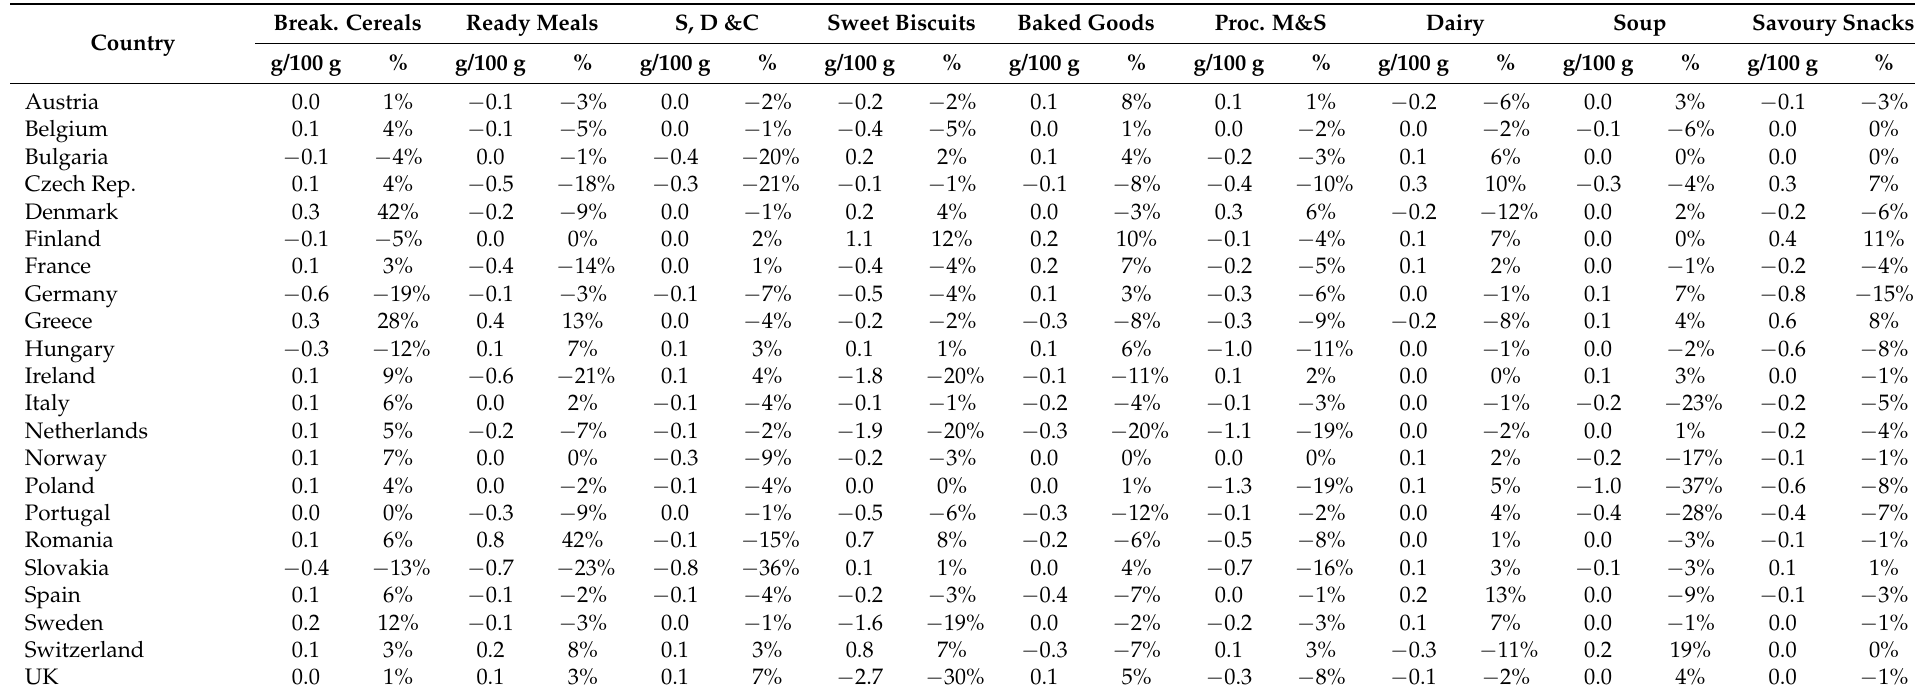
Table A4. Changes in the market-share weighted mean of saturated fat (in g/100 g and %) between 2015 and